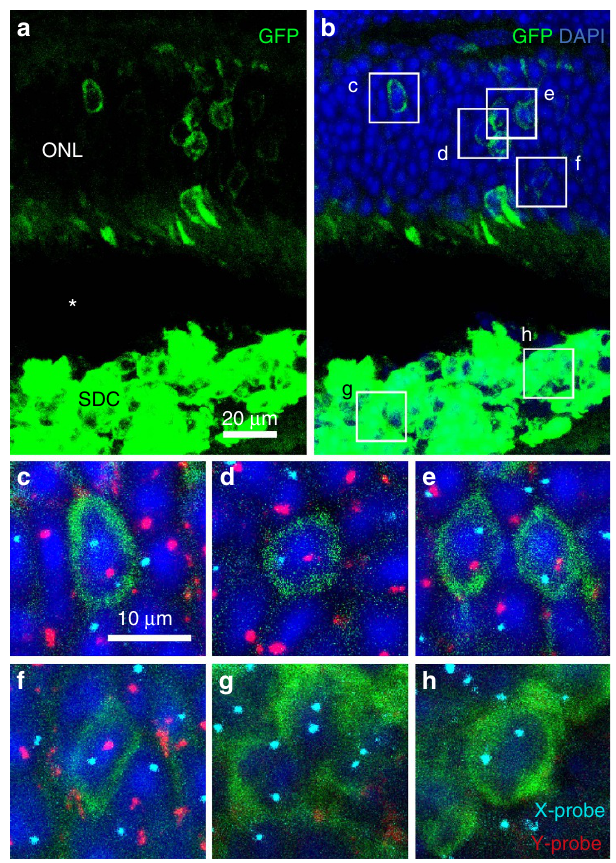
Figure 2 | The nuclei of GFP-positive donor cells in the host ONL contain the Ychromosome that is only present in the host. ( a , b ) Projection images showing donor photoreceptor precursor cells from P3 female Nrl.GFP mice that were transplanted into the subretinal space of an adult male wild-type host.The asterisk is a separation of the subretinal donor cells (SDCs) from the ONL due to a histological artefact. GFP-positive cells in the male host photoreceptor layer can clearly be seen to contain Y-positive nuclei ( c – f ). ( g , h ) GFP-positive cells in the subretinal donor cell mass contain only X chromosomes.